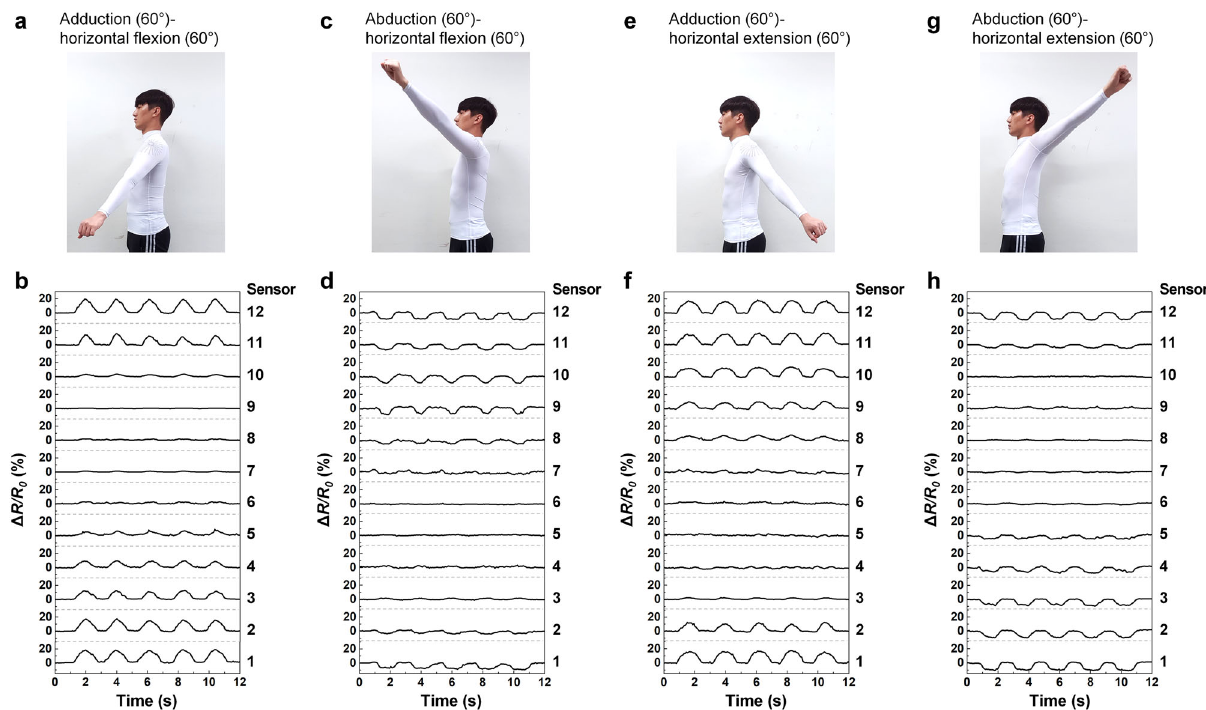
Fig. 5 Real-time monitoring of shoulder motion at various rotational angles. The positions of the left shoulder during the evaluation are indicated in panels ( a ), ( c ), ( e ), and ( g ). Electrical characteristics (change in resistance) obtained from the fi ber arrayed fabric sensor during b adduction (60°)-horizontal fl exion (60°), d abduction (60°)-horizontal fl exion (60°), f adduction (60°)-horizontal extension (60°), and h abduction (60°)-horizontal extension (60°). I, M. Son, consent to the use of my picture in connection with the